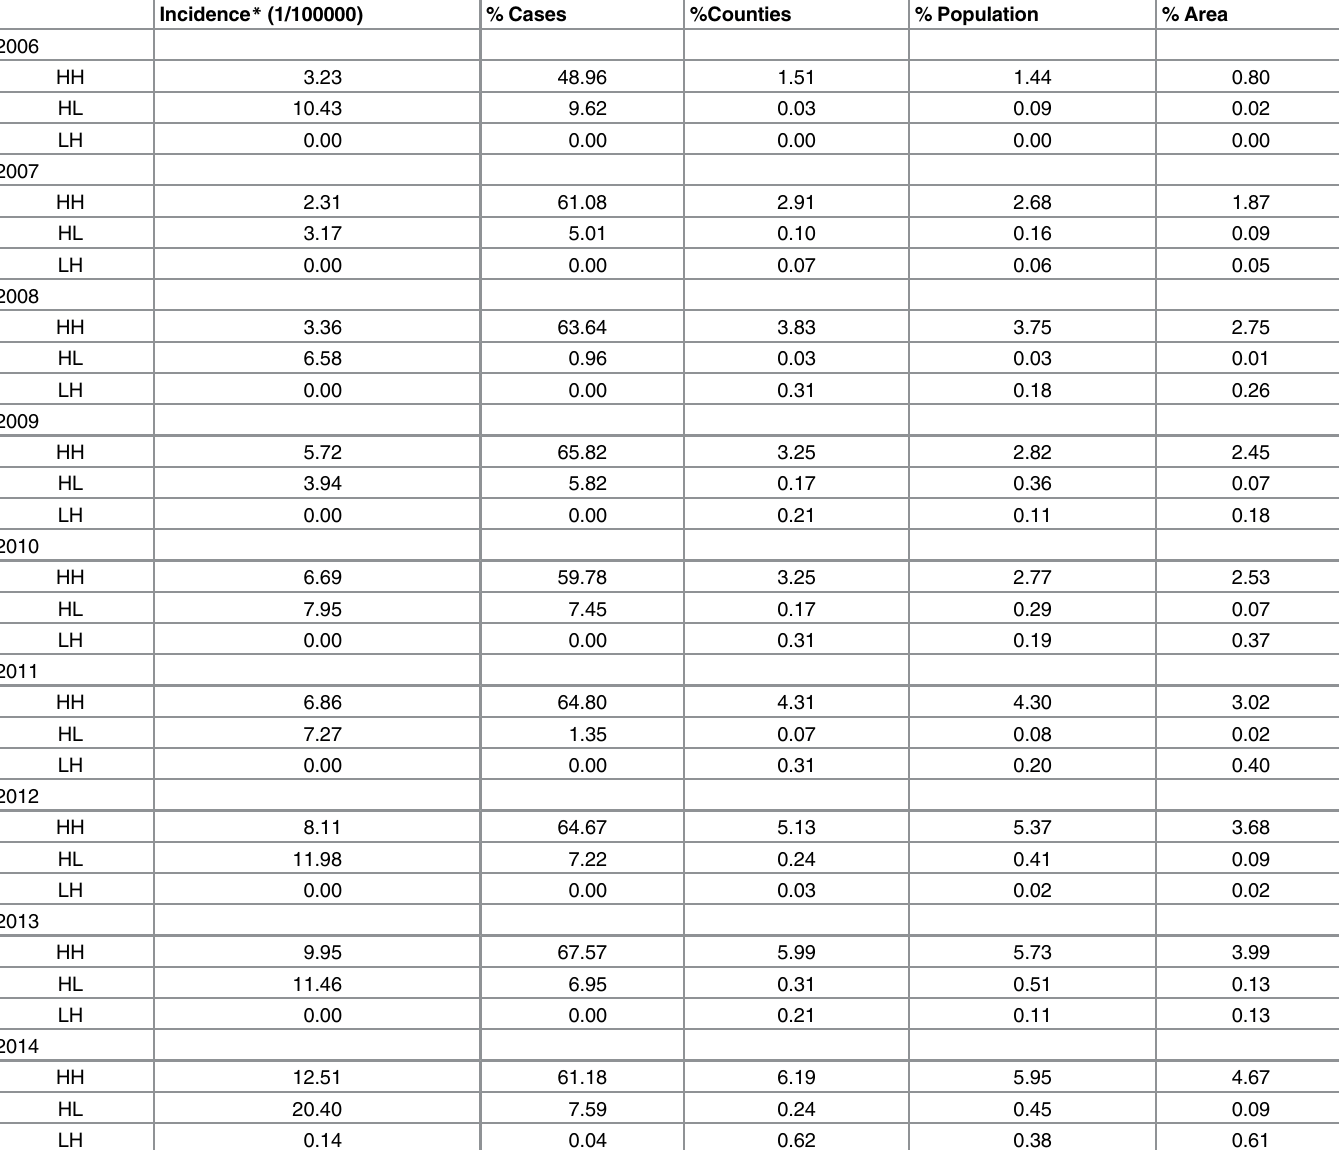
Table 2. Descriptive statistics of scrub typhus spatial clusters detected by Local Indicators of Spatial Association analysis in mainland China, 2006 – 2014. Incidence * (1/100000) % Cases %Counties % Population